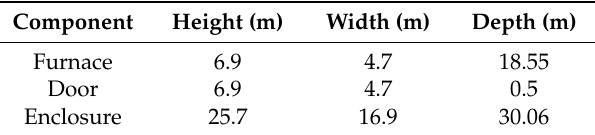
Table 1. Model components dimensions.